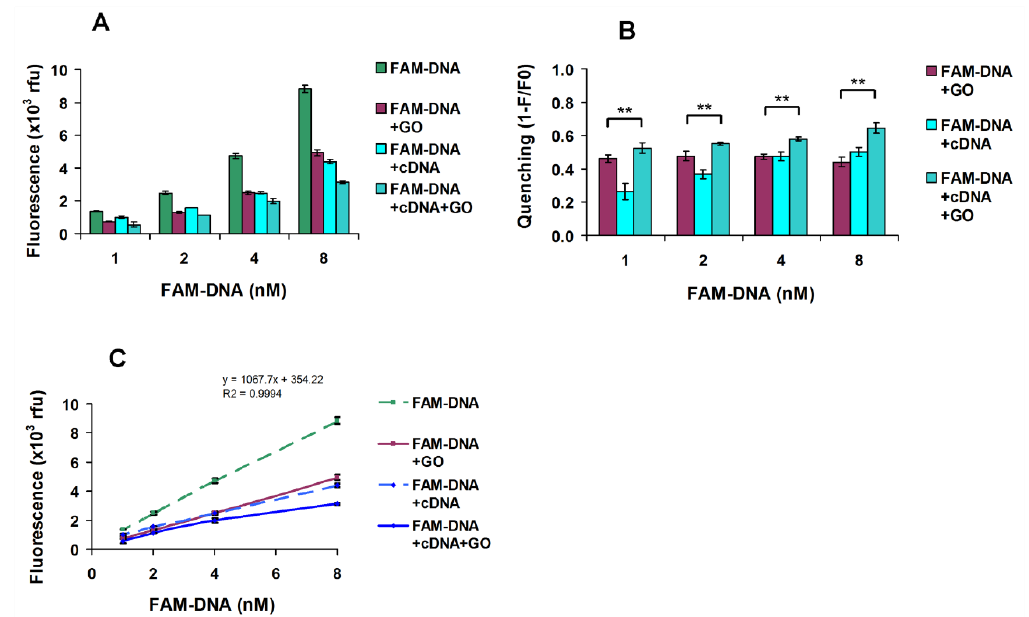
Figure 5. FAM–DNA bound to GO in the presence of bovine serum albumin (BSA), sodium dodecyl sulfate (SDS) and sodium chloride (NaCl). ( A ) Experiments using detection method 2; FAM–DNA fluorescence values were plotted as relative fluorescence units for each of the following samples: FAM–DNA alone, FAM–DNA with the addition of GO, FAM–DNA probe combined with cDNA target and pre-hybridized FAM–DNA + cDNA treated with GO, in the presence of 0.1% SDS, 0.1 mg / mL BSA and 6 mM NaCl. ( B ) Histogram of the extent of quenching due to FAM–DNA probe binding GO alone, reflecting FRET, upon FAM–DNA + cDNA hybridization, reflecting photoinduced electron transfer (PET), and after the addition of GO to pre-hybridized FAM–DNA + cDNA for one hour. ( C ) Linear plot of fluorescence values for FAM–DNA probe alone, FAM–DNA treated with GO, FAM–DNA + cDNA, and pre-hybridized FAM–DNA + cDNA treated with GO for increasing concentrations of FAM–DNA probes (from 1 to 8 nM) and cDNA targets in a 1:1 molar ratio. Error bars represent SD of n = 3. p -value; ** p ≤